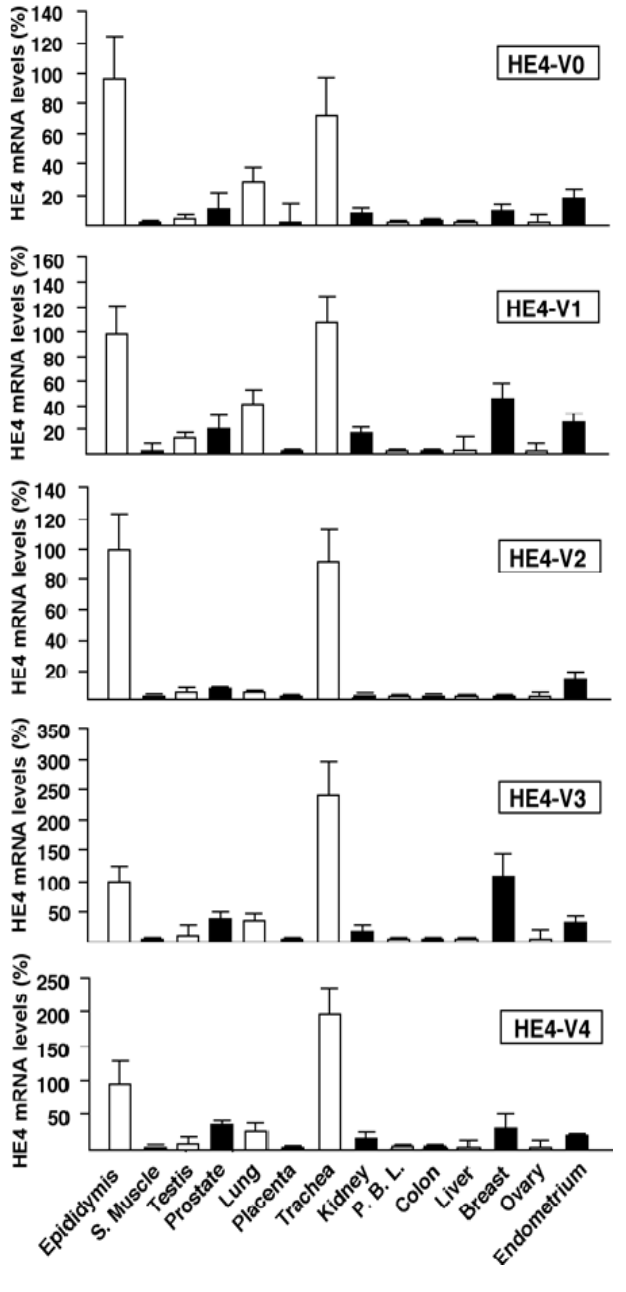
Figure 3. HE4 variant expression levels in normal tissues. Total RNA was extracted from 14 types of normal human tissues: epididymis, skeletal muscle (S. Muscle), testis, prostate, lung, placenta, trachea, kidney, peripheral blood lymphocyte (PBL), colon, liver, breast, ovary and endometrium. Reverse transcription and real-time PCR were performed on these samples. The expression levels of each variant in different tissues were normalized by the level of epididymis (set as 100). The mRNA levels of HE4 were ranked in three groups: <5% was ranked as low, 5%–50% was ranked as moderate, >50% was ranked as high. In general, all the variants were expressed at the highest levels in epididymis or trachea, moderate levels in prostate, lung, breast and endometrium, and very low levels in skeletal muscle, testis, placenta, kidney, PBL, colon and